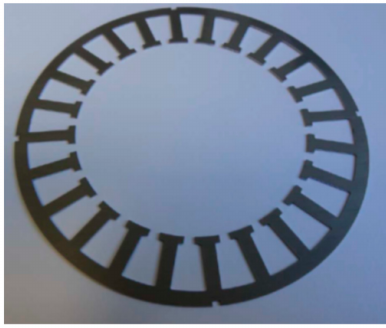
Figure 6. Laminated stator.